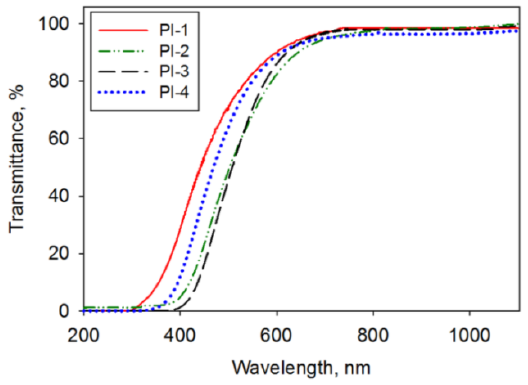
Figure 2. The UV-VIS-NIR spectra recorded for the PI-1, PI-2, PI-3, and PI-4 films.